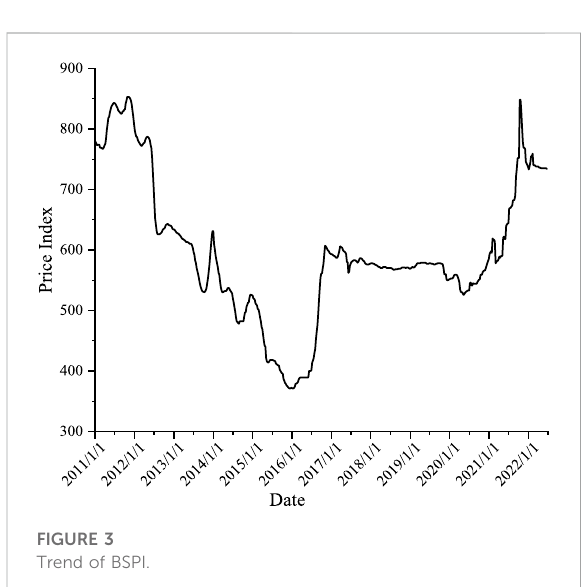
FIGURE 3 Trend of